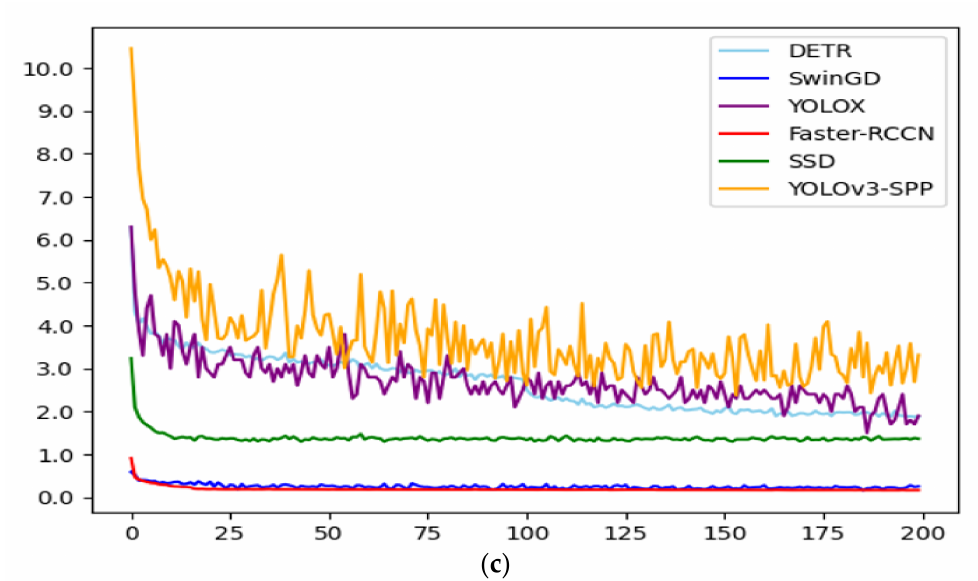
Figure 6. Result analysis: ( a ) the mAP results of various models in case of IoU = 0.5; ( b ) the mAP results of various models in case of IoU = 0.50:0.05:0.95; ( c ) training loss of various